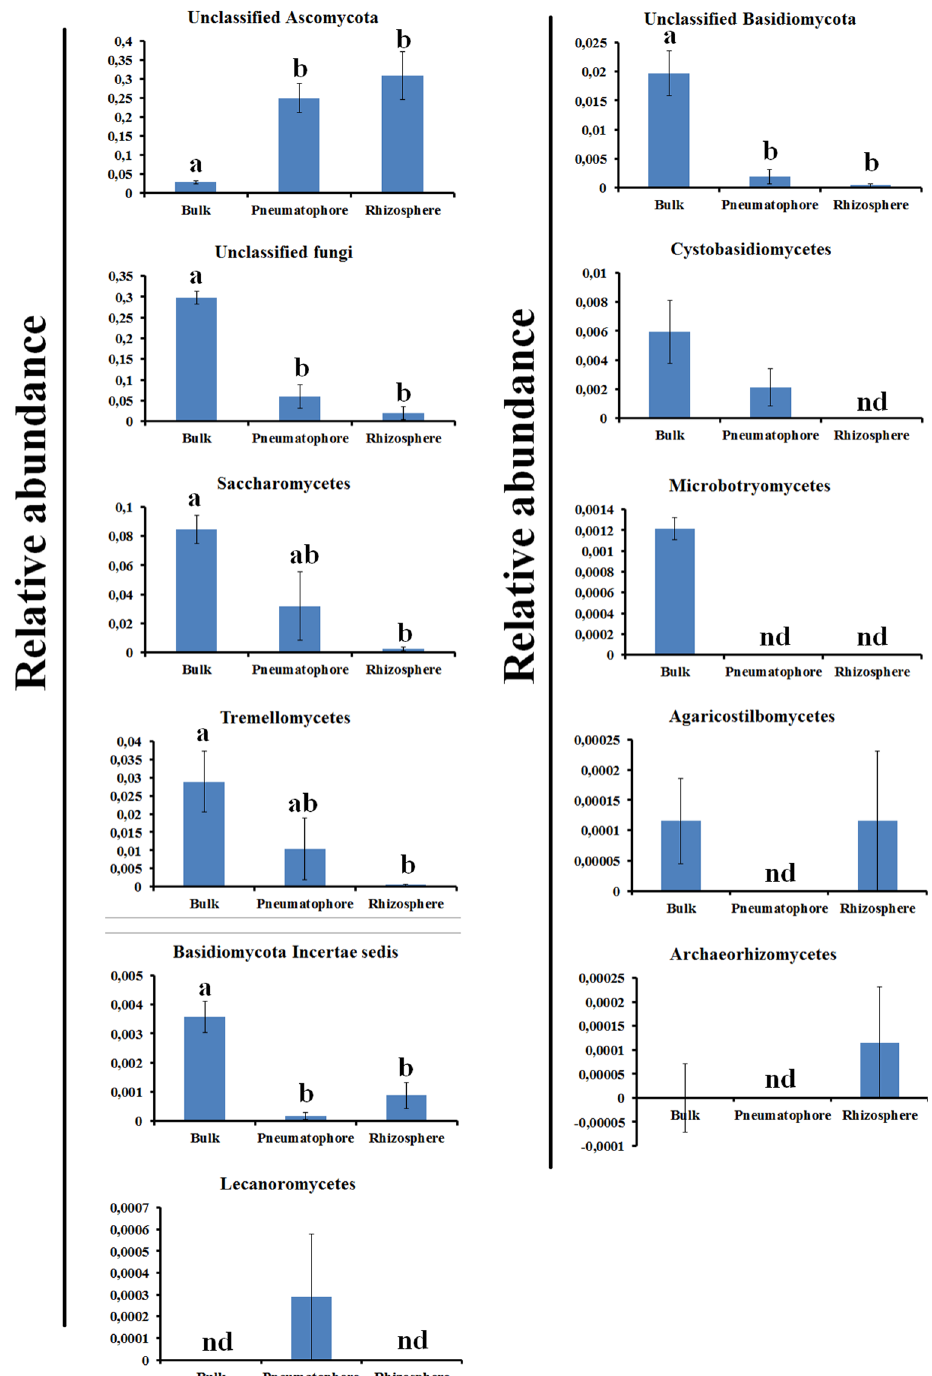
Figure 5. Differentially abundant fungal classes across the compartments. OTUs were clustered at 97% similarity level. The different alphabet (a,b and ab) denotes significance at 0.05 (Bonferroni correction). The letter “nd” denotes “not